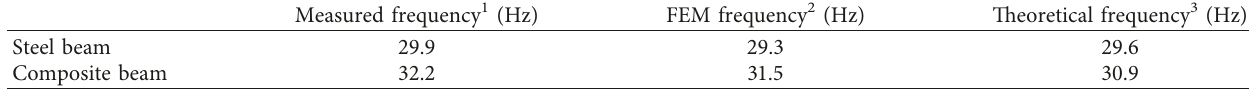
Table 3: Comparison of results of vertical bending natural frequency when α � 0.9.